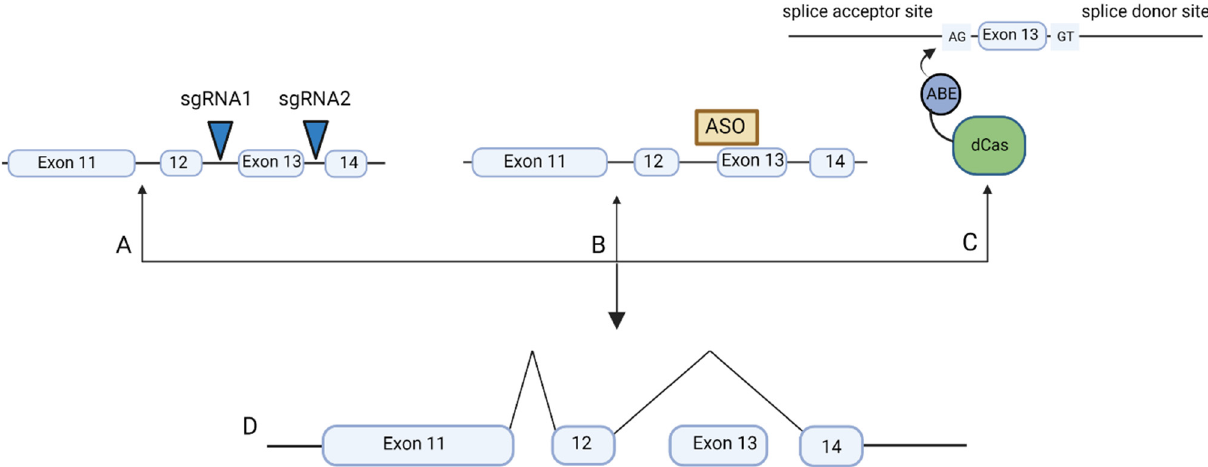
Figure 2. Gene therapy options for removing/skipping USH2A exon 13. ( A ) Excision of exon 13 with two sgRNAs that create DSB’s in the flanking introns, ( B ) Exon skipping of exon 13 mediated by antisense oligonucleotides, ( C ) Exon skipping mediated by base editing of the splice acceptor site ( D ) The final mRNA sequence excluding Exon 13 leading to a functional protein Created with Bio- Render.com (accessed on 22 August 2022). BioRender.com (accessed on 22 August